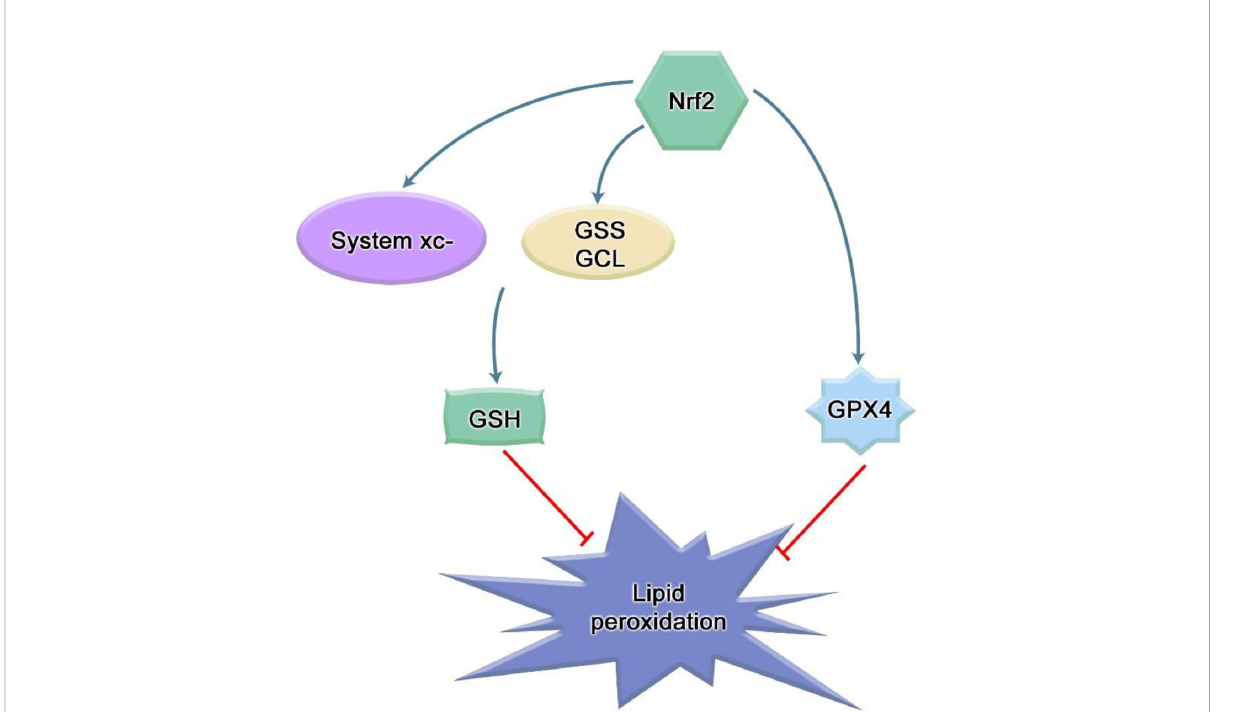
FIGURE 3 Mechanism of Nrf2 inhibiting lipid peroxidation. The cystine/glutamic acid reverse transporter on the cell membrane, namely, system xc-, is responsible for the uptake of cystine and the excretion of glutamic acid. The ingested cystine provides the raw material for intracellular